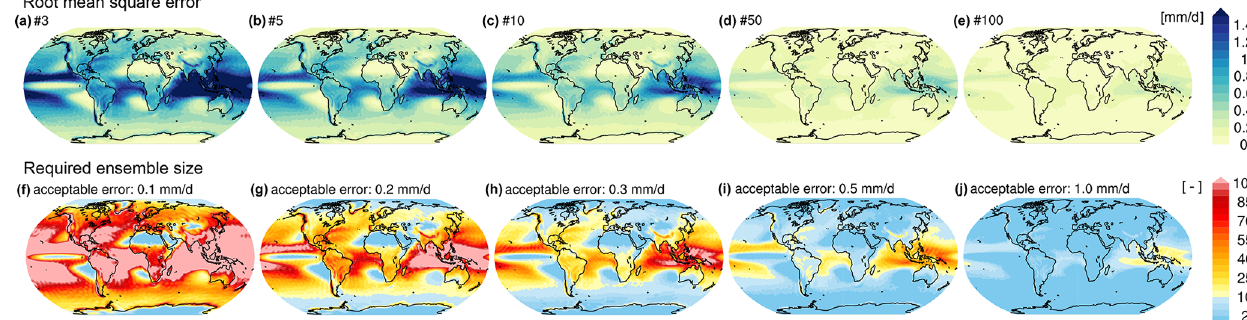
Figure 4. (a–e) The mean RMSE for the forced response in historical monthly mean total precipitation of MPI-GE for (a) 3, (b) 5, (c) 10, (d) 50, and (e) 100 ensemble members relative to the 200-member mean, globally. The RMSE shown here is the mean from 100 random samples without replacement. (f–j) Required ensemble size to capture the 200-member mean forced response in historical monthly mean total precipitation dependent on the acceptable error of (f) 0.1, (g) 0.2, (h) 0.3, (i) 0.5, and (j) 1.0mmd − 1